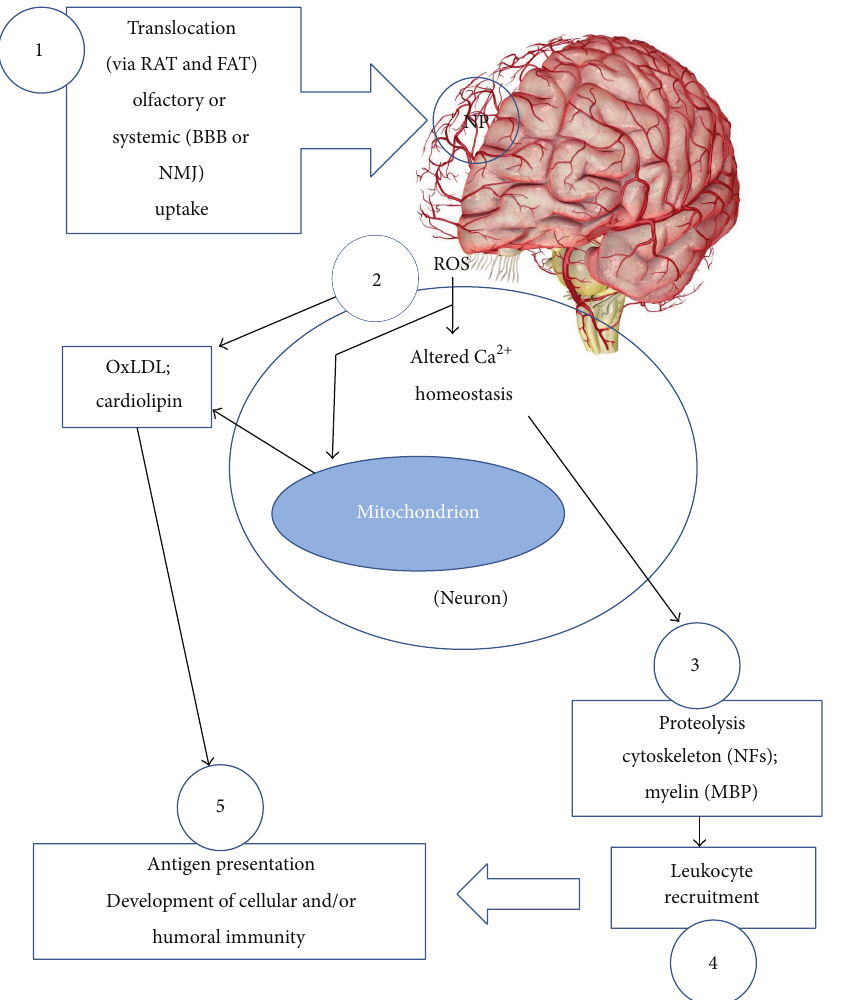
Figure 6: Mechanisms by which NP produce neurotoxicity and resulting autoantibody generation. (1) Translocation of NP introduced via the olfactory bulbs (or neuromuscular junction: NMJ) to the nervous system via retrograde (RAT) and fast anterograde (FAT) transport; (2) translocated NP may induce lipid peroxidation (e.g., LDL) and oxidative stress, as well as Ca 2+ overload and displacement from ER/mitochondria; (3) cytoskeletal proteolysis, as a result of Ca 2+ overload, which also results in mitochondrial derangement (e.g., cardiolipin dissociation).Theseeventsresultinexposureofautoantigens;(4)recruitmentofimmuneeffectors,includingmicroglia, in situ ,andperipheral leukocytes; (5) antigen processing, presentation, and antibody production in lymphoid